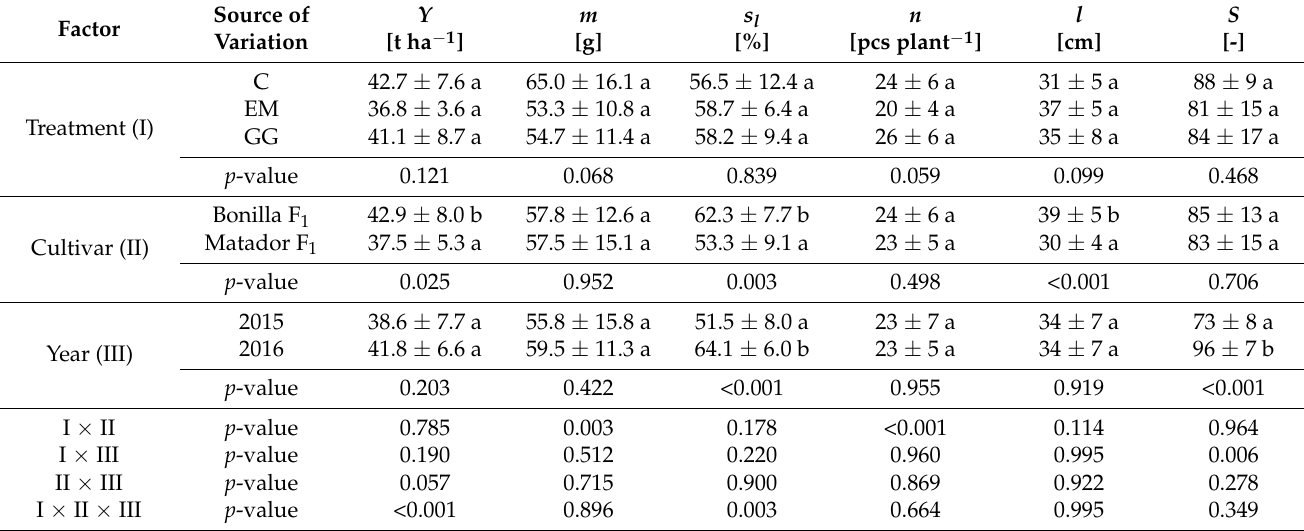
Table 3. Morphological parameters and marketable yield of